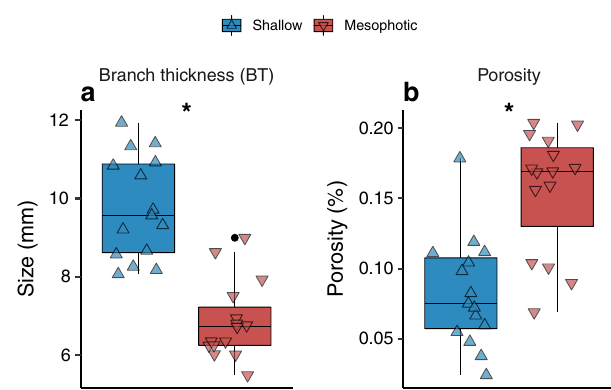
Fig. 3 Branch thickness and porosity of shallow and mesophotic S. pistillata colonies. Box plots showing a branch thickness and b porosity between shallow (blue; triangle point up) and mesophotic (red; triangle point down) Stylophora corals ( n = 15 per depth). Horizontal lines depict the median, box height depicts the interquartile range, whiskers depict ±1.5× interquartile range, and dots represent outliers. Asterisk denotes signi fi cance ( p <